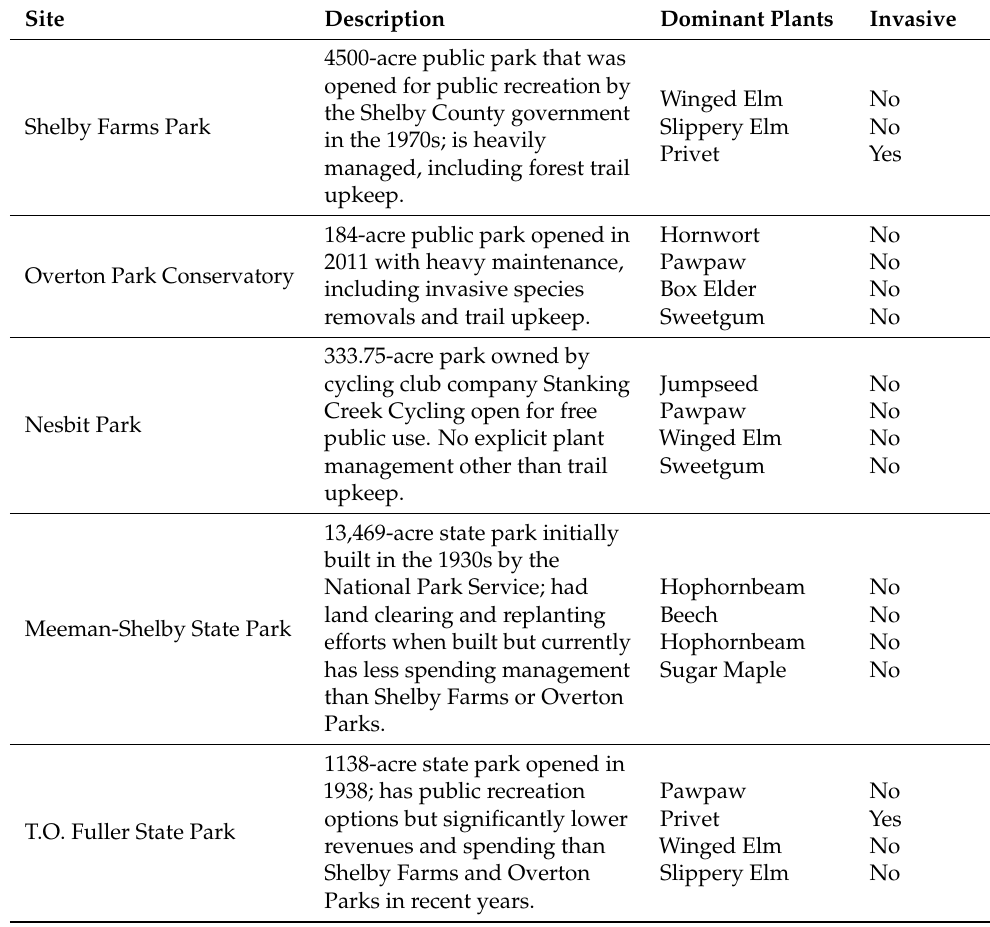
Table 1. Site descriptions for samples collected in Memphis, TN, Summer 2022. Shelby Farms and Overton have more overall current funding, and consequently more management and human oversight, than Nesbit, Meem.an-Shelby, and T.O. Fuller